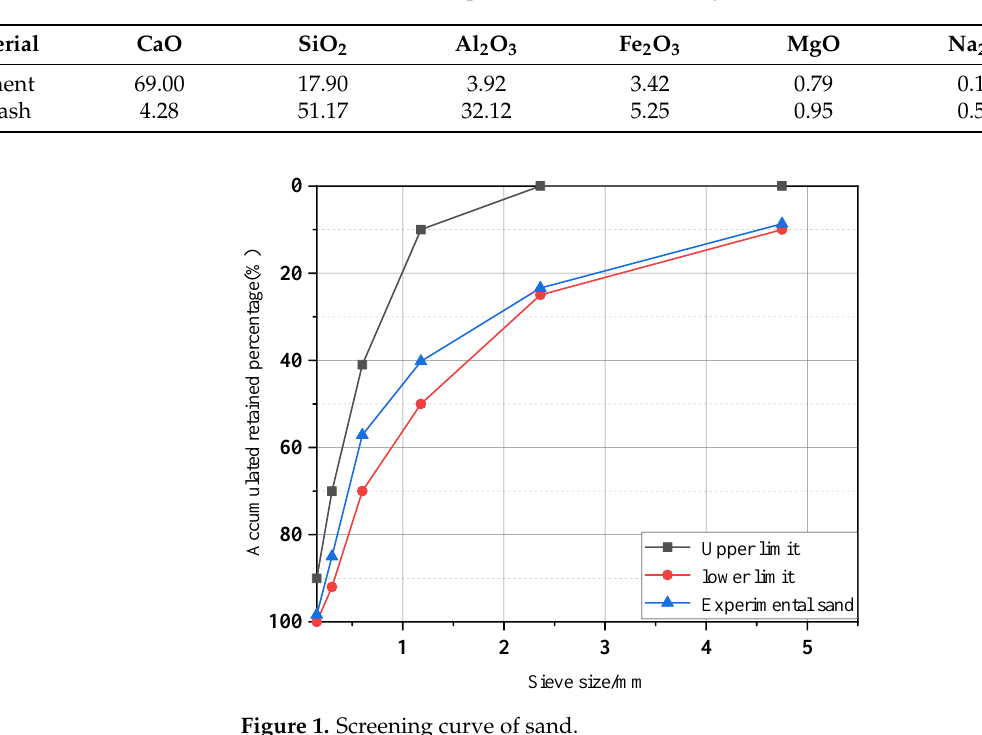
Table 1. Chemical composition of cement and fly ash (mass fraction/%).